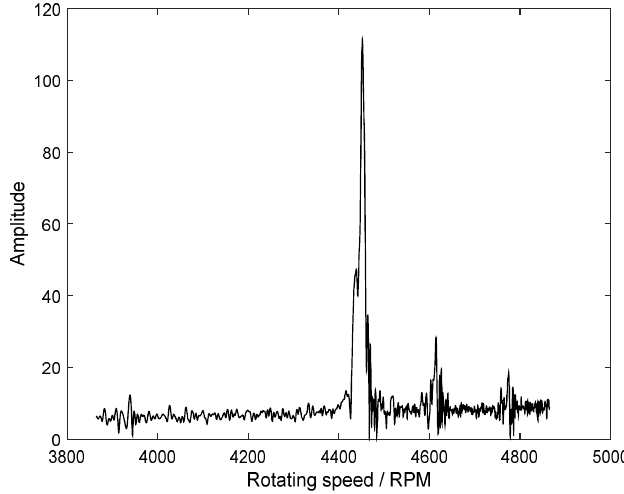
Figure 23. Order tracking spectrum of the 30th EO .